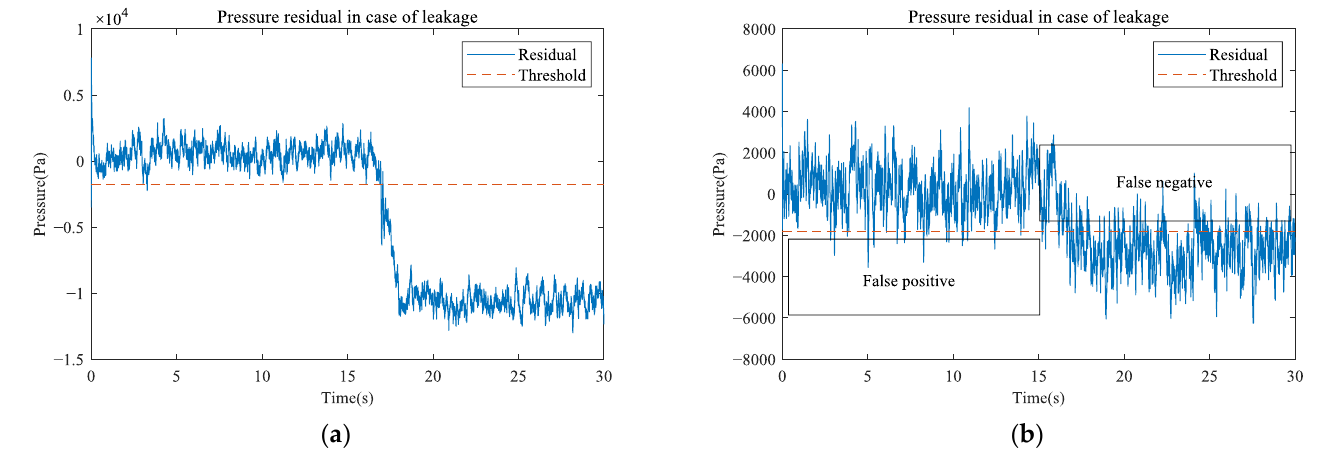
Figure 7. Residual between the model output and actual pressure at the outlet of the pipeline when leakage occurred. ( a ) Large leakage; ( b ) small leakage.